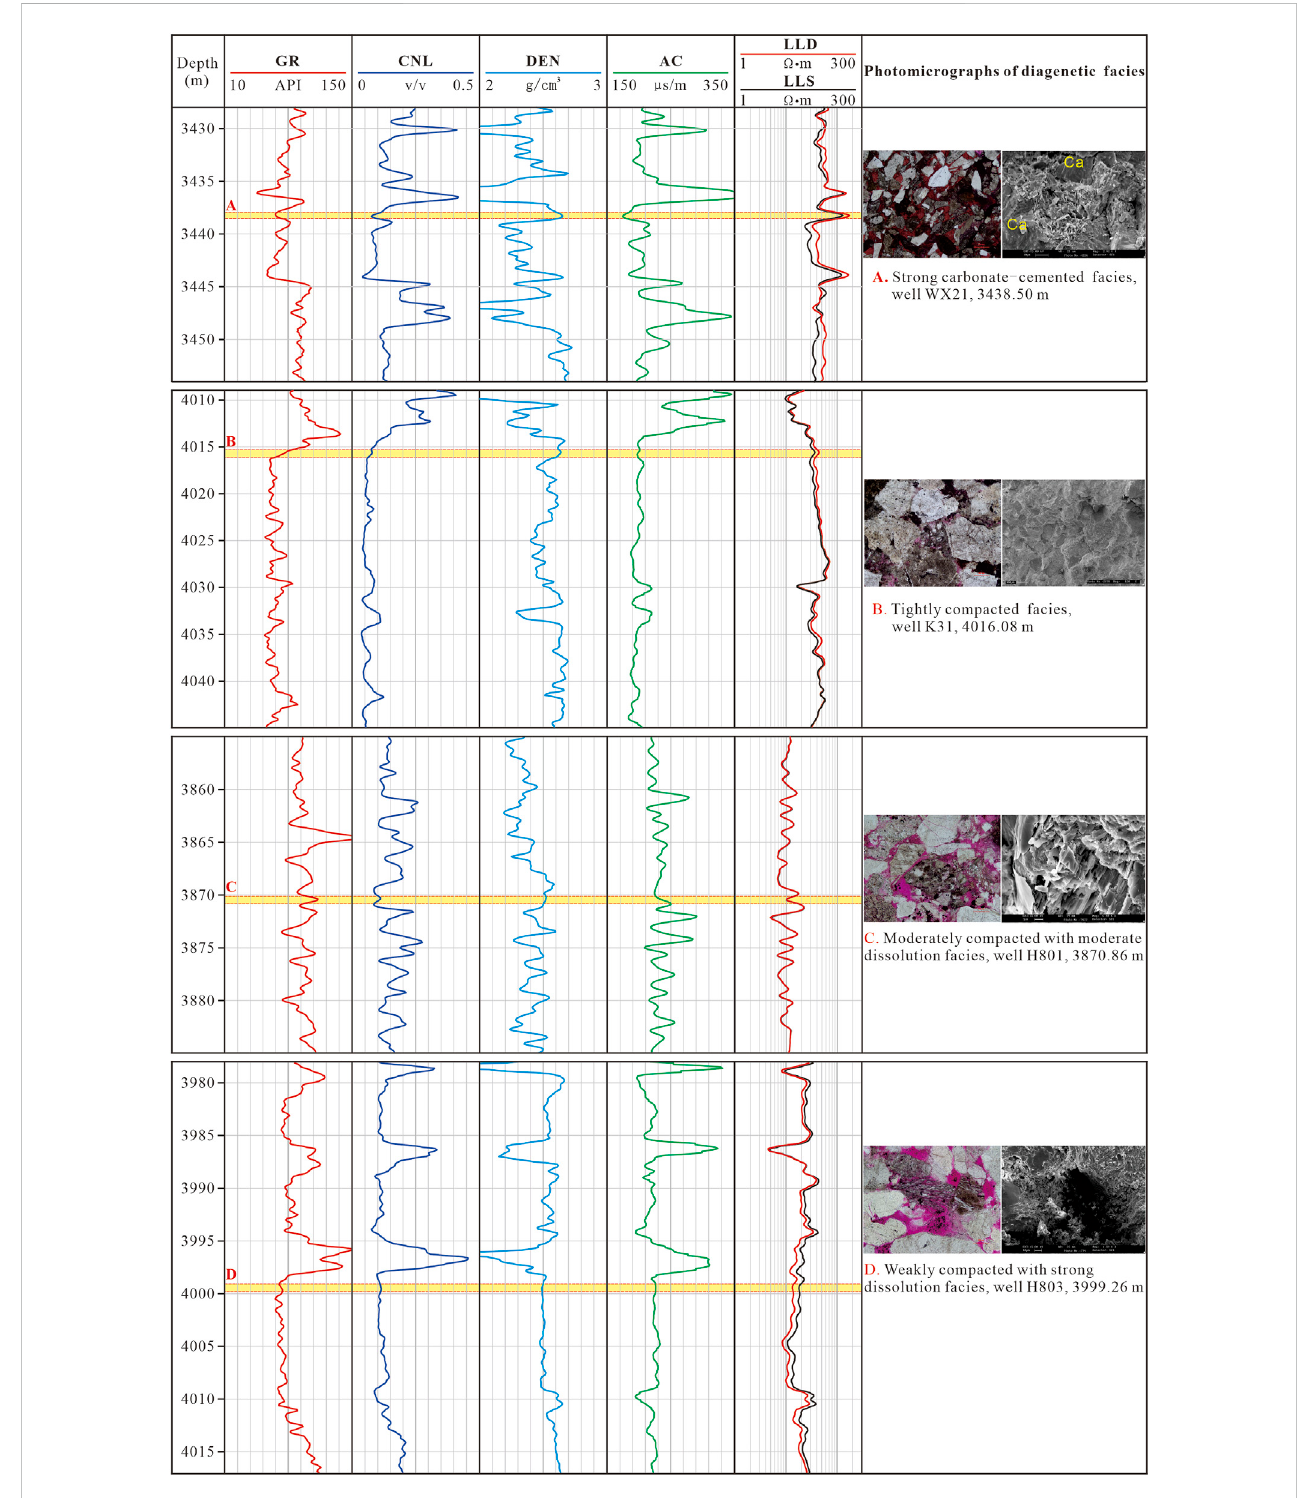
FIGURE 12 The typical photomicrographs and corresponding well log responses of different types of diagenetic